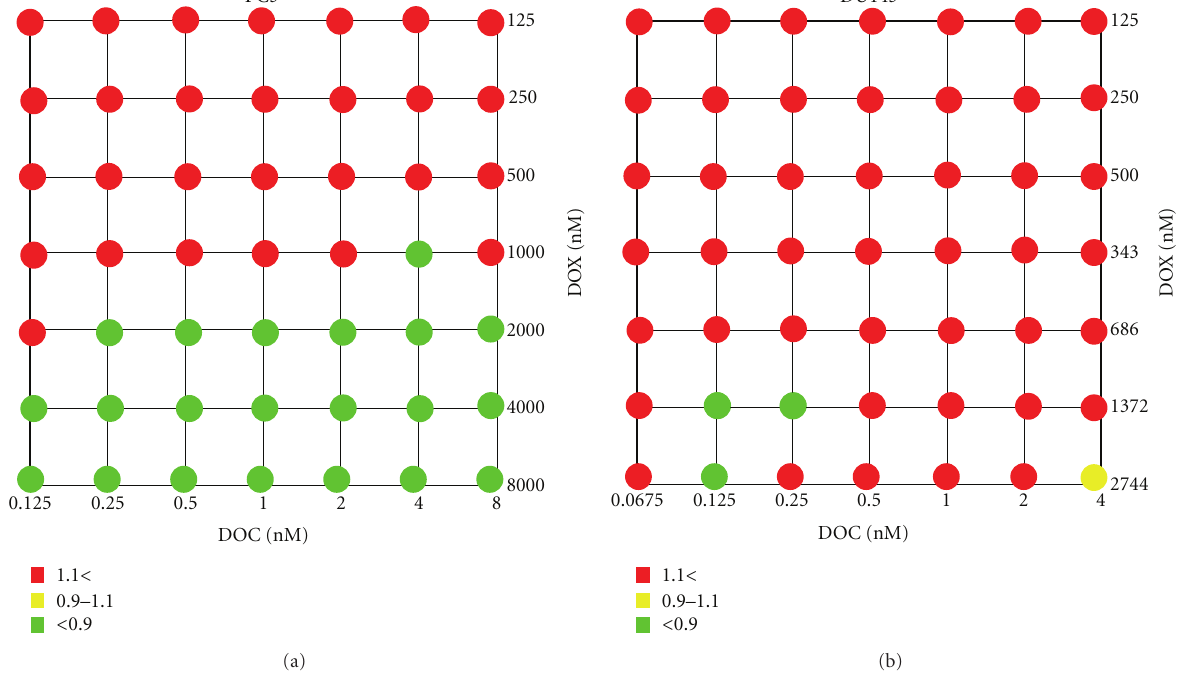
Figure 5: Focused synergy maps compiling combination index (CI) values. The CI values were determined with a narrower dose area with 7 × 7 drug combination design. Drug antagonism (red), additivity (yellow), and synergism (green) were determined for PC3 and DU145 cells exposed to DOC and DOX for 72